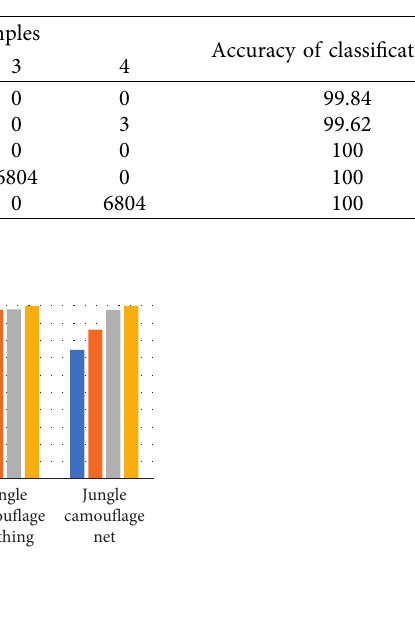
Figure 8: Classification results of NB, KNN, RF, and SVM. Table 5: Classification accuracy of four